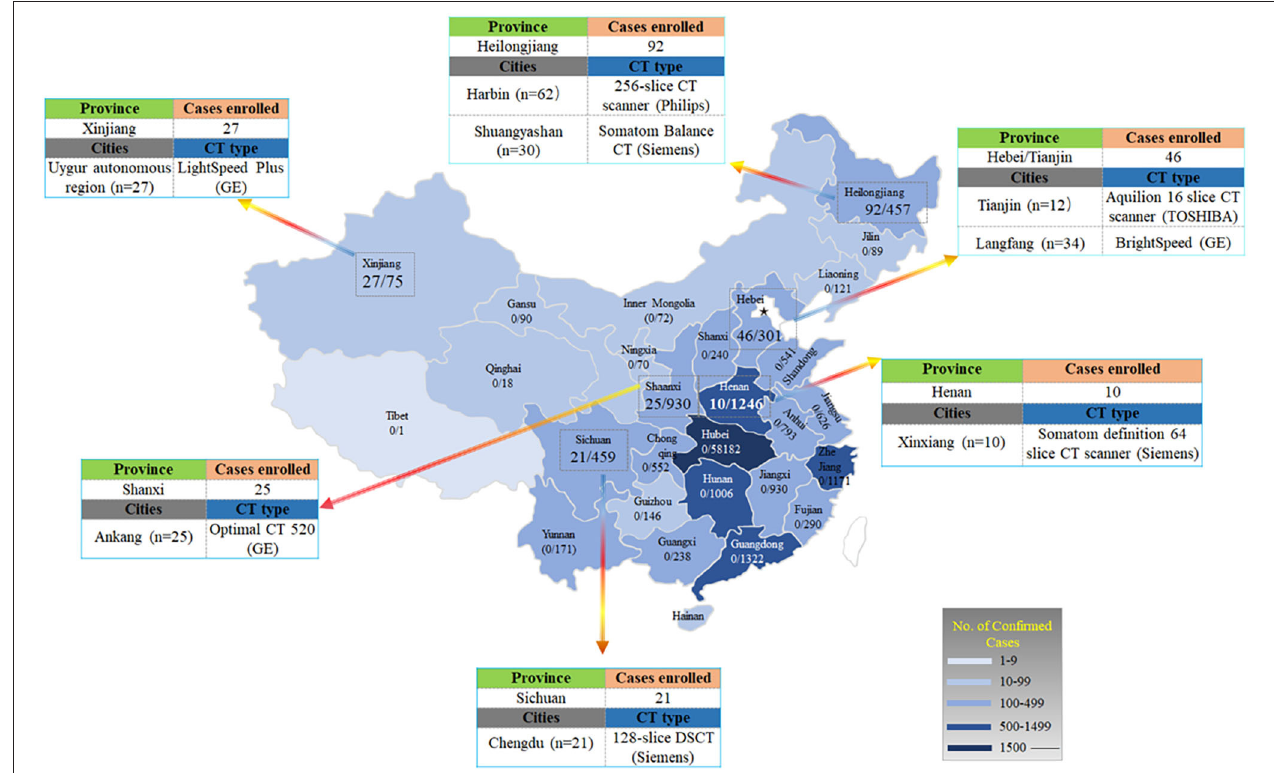
FIGURE 2 | Distribution of patients with COVID-19 across China. It shows the official statistics of all documented, laboratory-confirmed cases of COVID-19 throughout China, according to the National Health Commission as of February 17, 2020. The numerator denotes the number of patients who were included in the study cohort and the denominator denotes the number of laboratory-confirmed cases for each province or autonomous region, as reported by the National Health Commission.